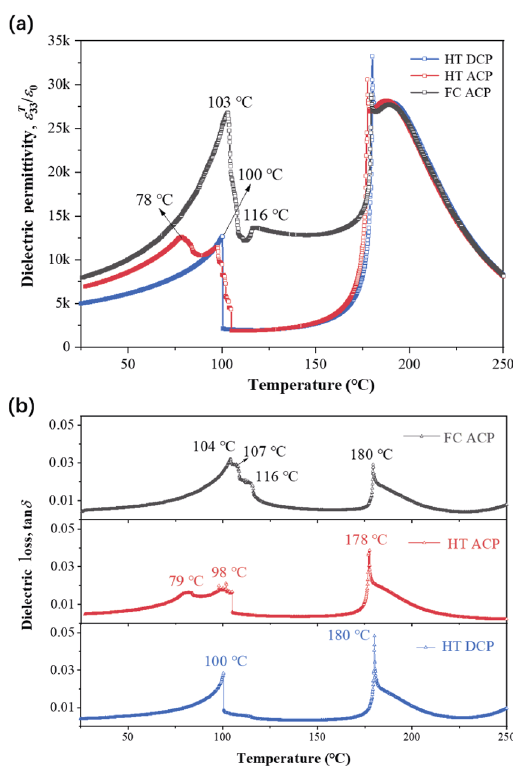
/ T   and (b) 33 0 / T   and (b) d 33 of various PMN-based 33 0 relaxor SCs, and their corresponding T pc and T C [4,11,12,